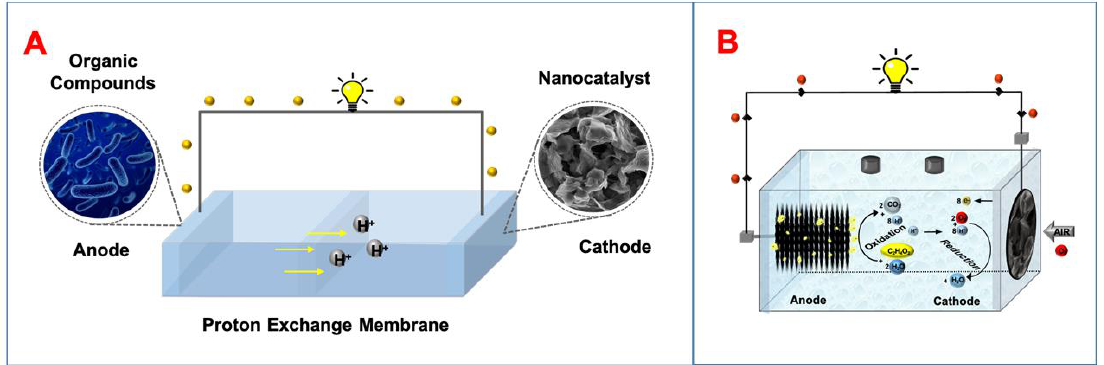
Figure 2. Schematic diagram of a two-chamber microbial fuel cell (MFC) ( A ) and a single-chamber MFC ( B ).